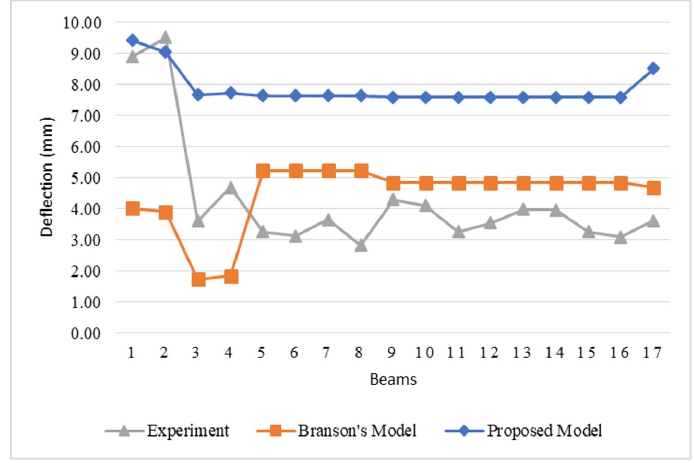
Figure 10. Beams with reinforcement rate from 0 to 1%.